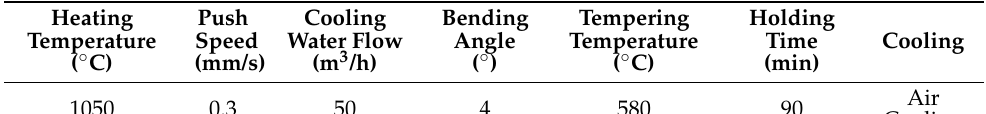
Table 2. Heat-induced bending parameters of the X80 × D1422 mm heavy-wall heat-induced seamless bend.